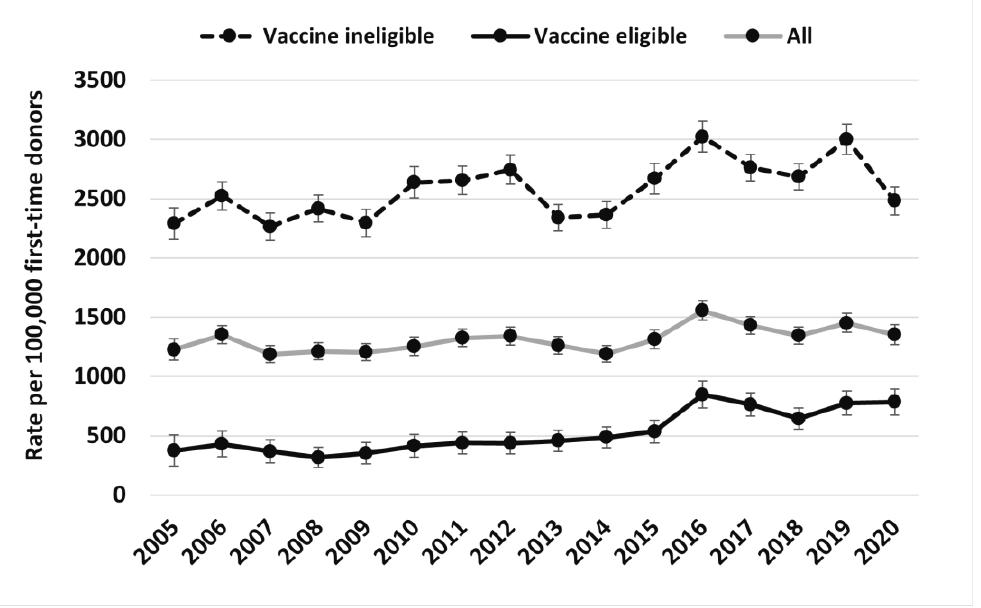
Figure 1. HBV clinical scenario 2 (likely chronic infection) rate (per 100,000 first-time donors) (95%